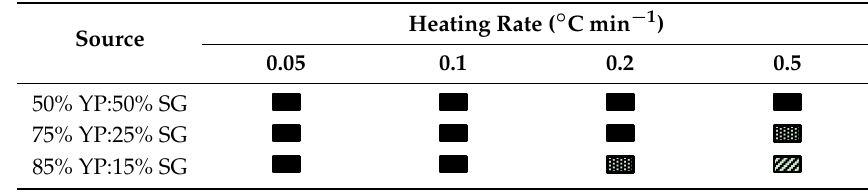
Table 5. Thermostabilization behavior of lignin fibers made from different ratios of switchgrass and yellow polar lignin blends.